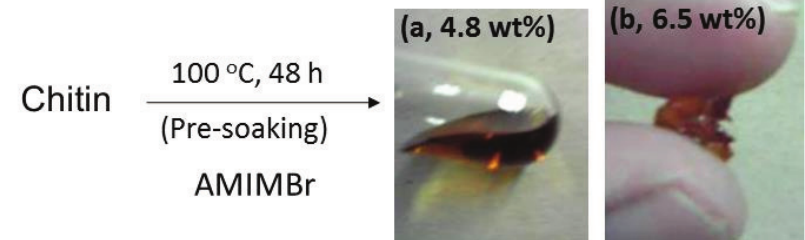
Figure 7. Dissolution ( a ) and gelation ( b ) of chitin with 1-allyl-3-methylimidazolium bromide